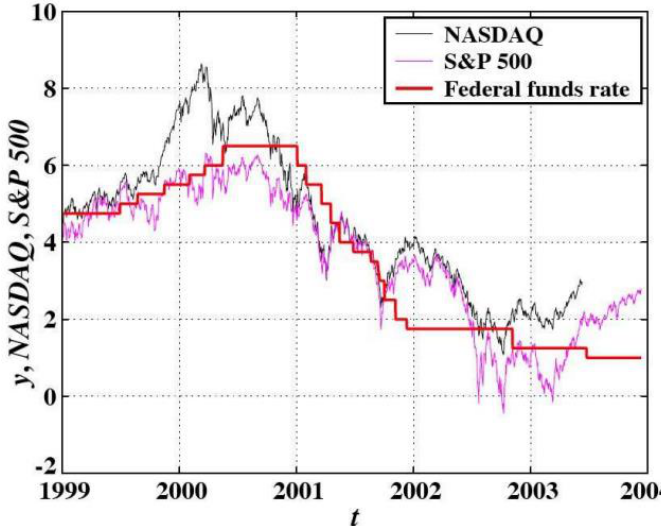
Figure 11. Comparison of the federal funds rate, the S&P500 and the Nasdaq Composite indices, from 1999 to mid-2003. The time series have been scaled vertically to allow for illustrative visual comparison (from